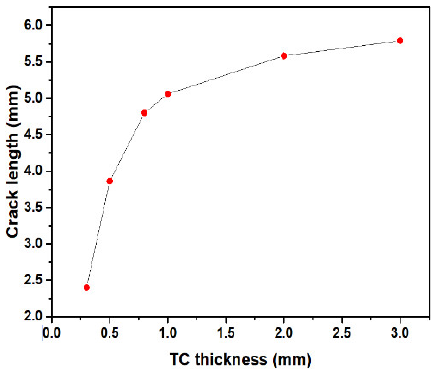
Figure 12. Plot of crack length as a function of thickness of ceramic coating.